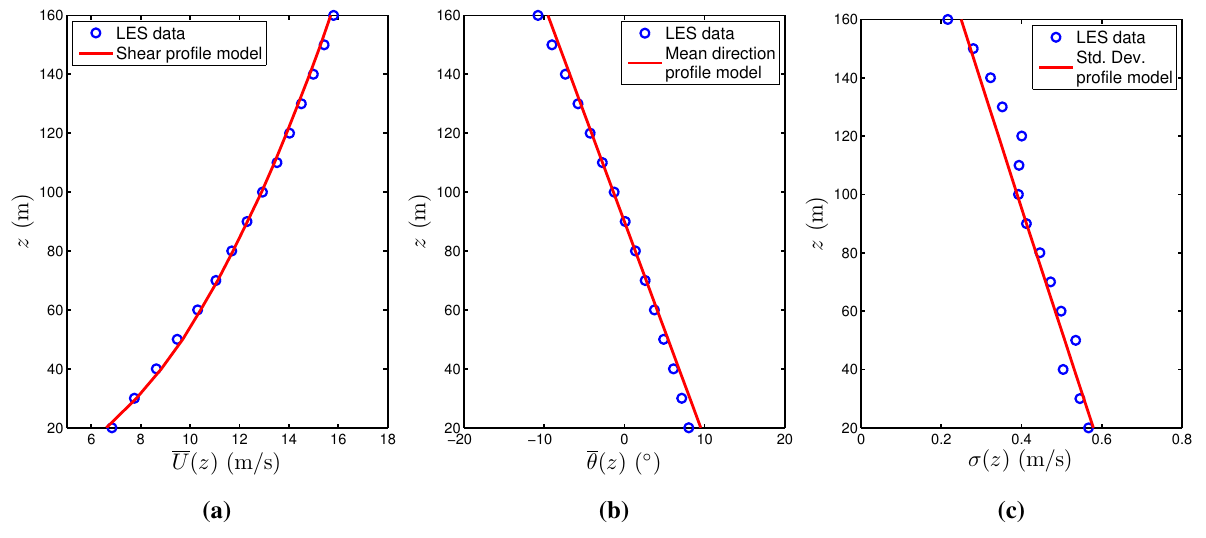
Figure 5. Mean wind speed, mean wind direction, and turbulence standard deviation vertical profiles and least squares fits for SBL flow fields from a single LES run. ( a ) fit using ˆ α ; ( b ) fit using ˆ S ; ( c ) fit using ˆ S θ σ